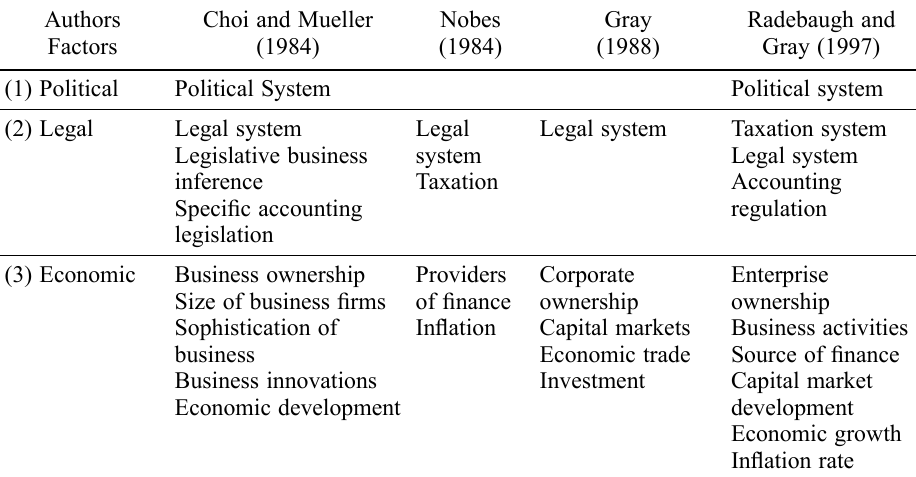
Table 1. Accounting influential